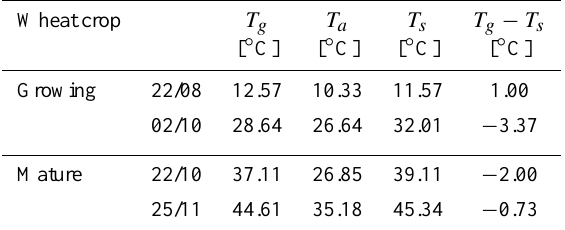
Table 1. Validation results for the Walpeup bare soil data set (Prata, 1994b). Rms LST error, standard deviation, and error range are given Coll and Caselles (1997)